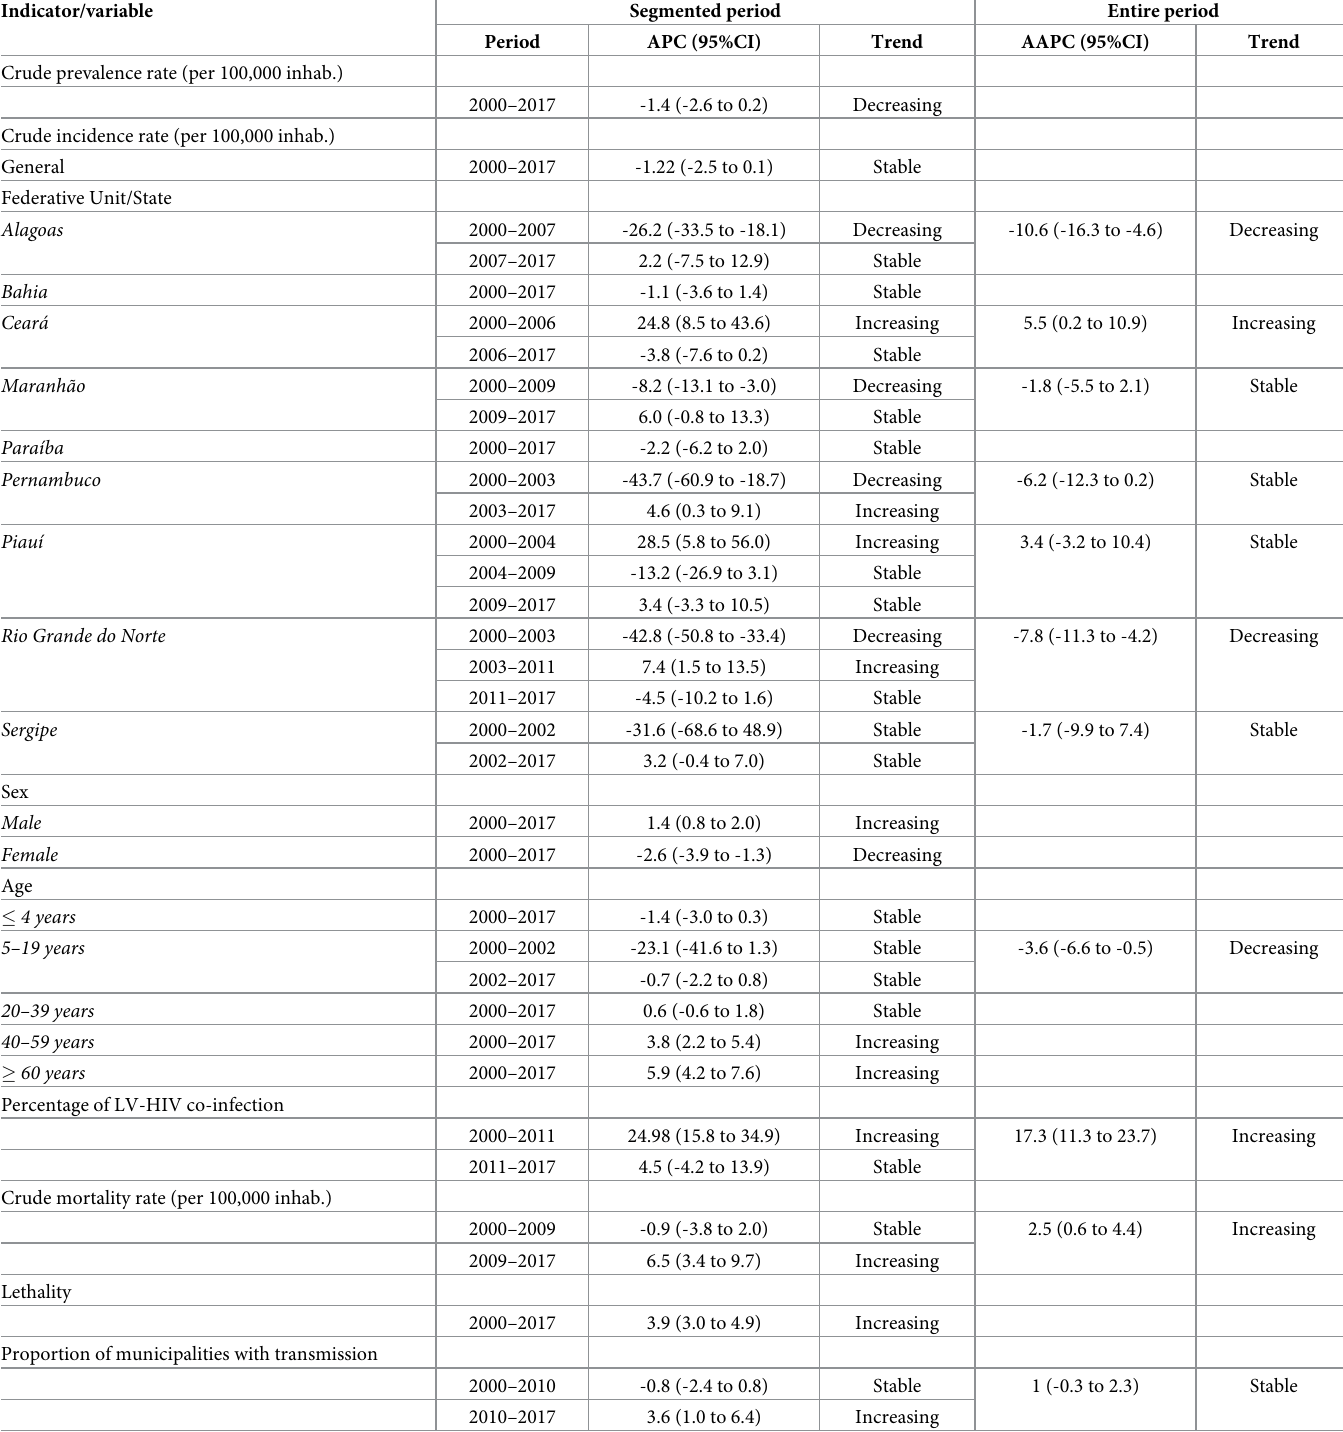
Table 3. Time trends of VL epidemiologic indicators.